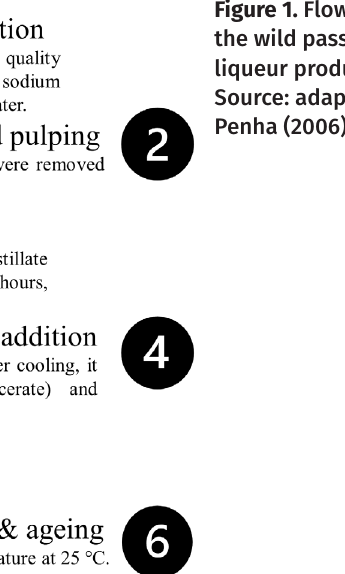
Figure 1. Flowsheet of the wild passion fruit liqueur production. Source: adapted from Penha